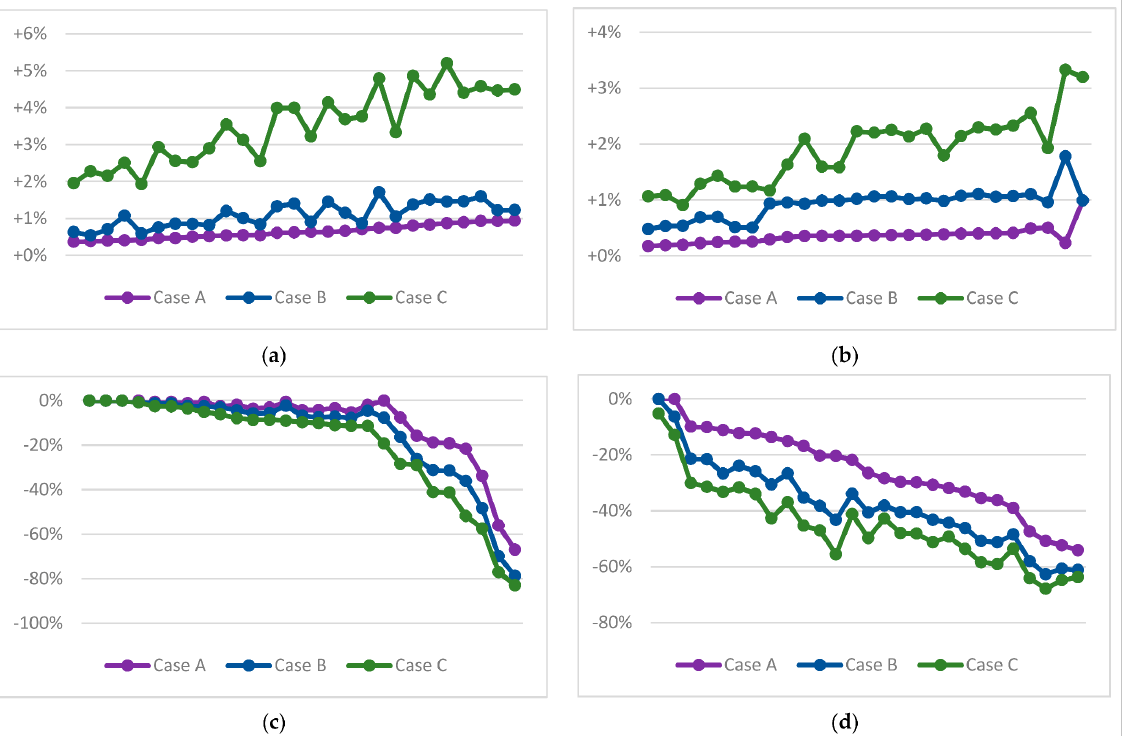
Figure 7. Distributions of the changing rates for: ( a ) amounts of rebars by cases for beam members; ( b ) also for slab members; ( c ) number of LPRS by cases for beam members; ( d ) also for slab